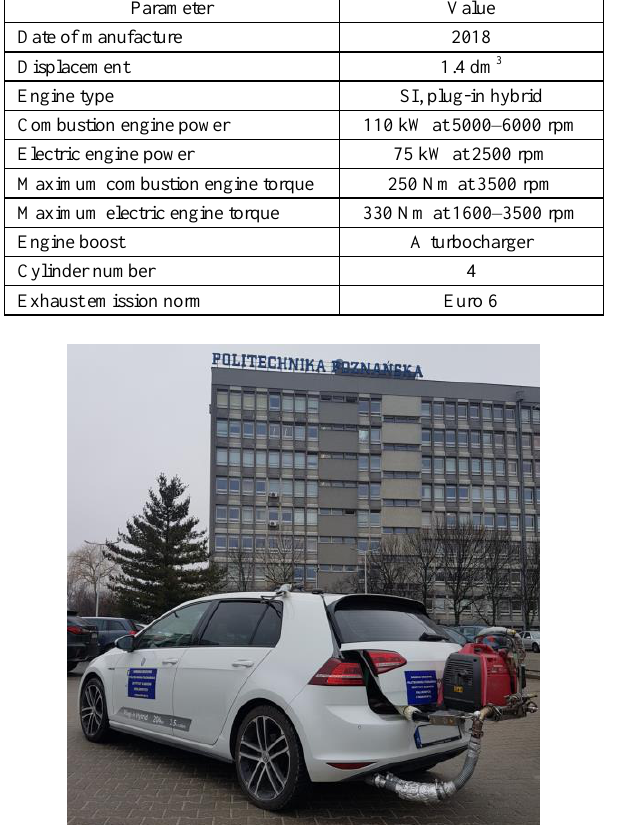
Fig. 3. The test vehicle equipped with the PEMS device during tests in real operating conditions